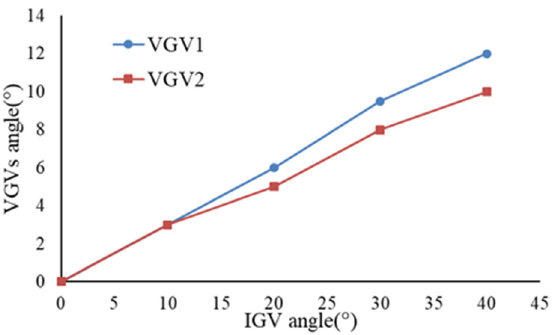
Figure 27. Relationship between the IGV opening degree and the optimal turning angle of VGVs. Performance curves of the original compressor and the compressor after VGV joint adjustment optimization are shown in Figure 28. When IGV (cid:3404) 0° , VGVs are not turned